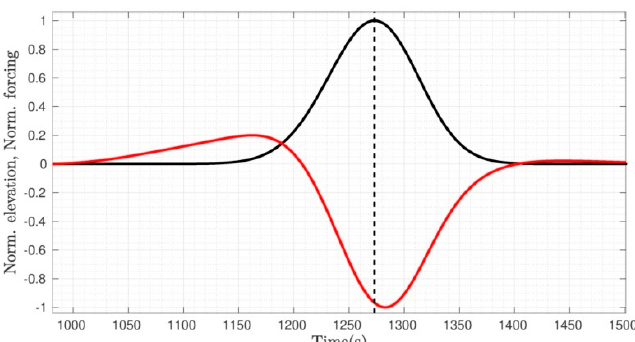
Figure 8. Time series of surface displacement (at x = − 100 m in Figure 7c), normalized by its absolute minimum value (red) and Gaussian-shape radiation stress normalized by its maximum value (black), for the longer forcing case shown in Figure 7b.